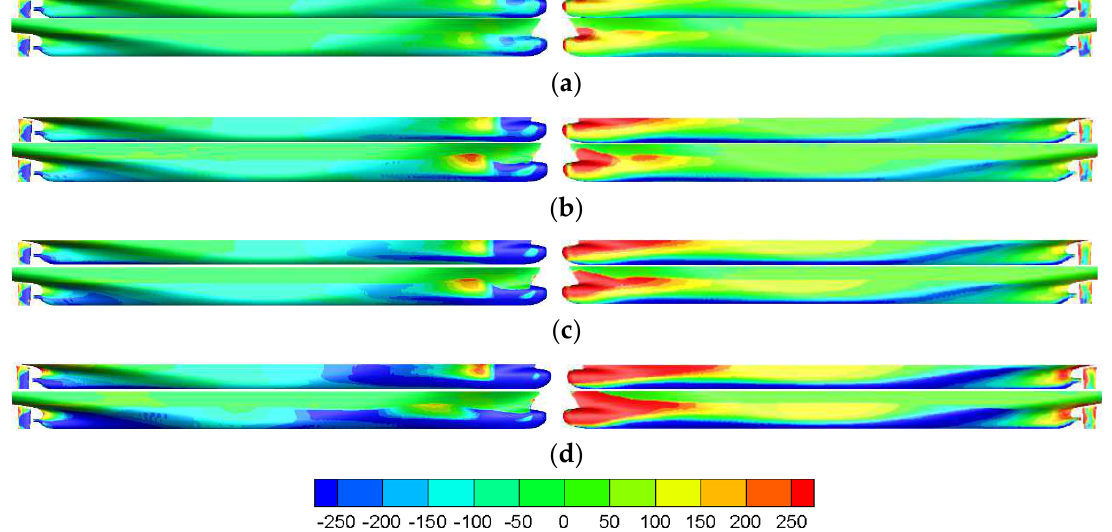
Figure 5. Dynamic pressure distribution on hull and rudder for simulations of double-body flow ( top ) and water–air flow ( bottom ). ( a ) Fr = 0.156, β = 16 deg. ( b ) Fr = 0.201, β = 16 deg. ( c ) Fr = 0.201, β = 20 deg. ( d ) Fr = 0.260, β = 20